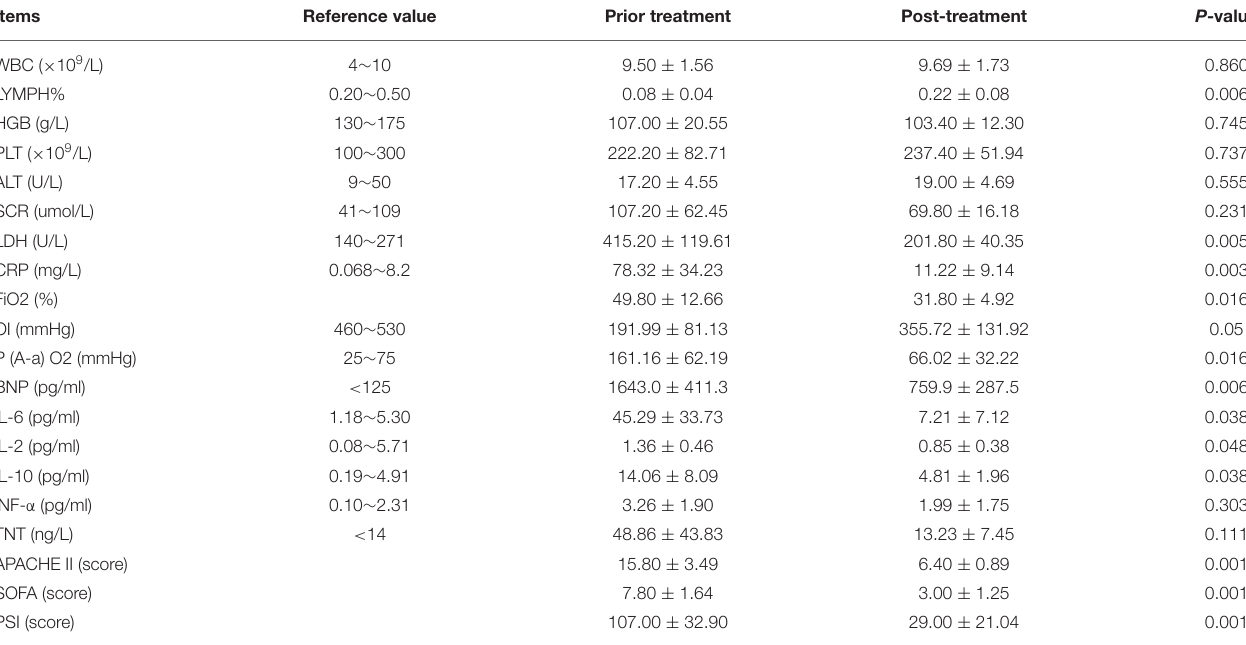
TABLE 2 | Laboratory indexes before and after blood purification.